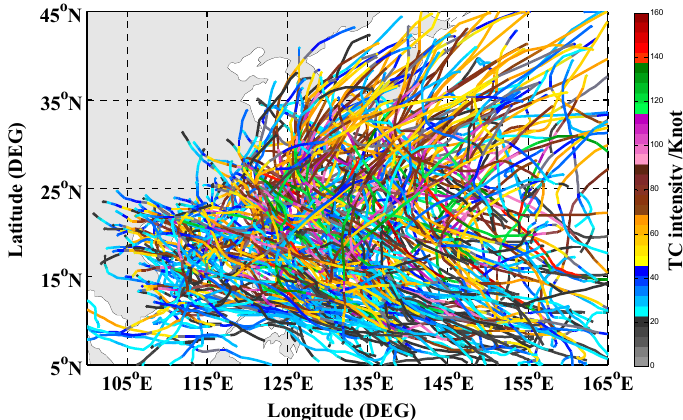
Figure 1. The region of interest in this paper, and tracks of the 325 cases adopted in training the model. The selected dataset comprises 18,108 three-hourly satellite images of 377 tropical cyclone cases from 1996 to 2009 NWP typhoon season. Of the 377 cases, 118 are tropical depression, 53 are tropical storm, 54 are typhoons, 36 are moderate typhoons, 26 are severe typhoons, 57 are super typhoons, and 33 are extreme typhoons. The 377 cases are divided into two groups. They are, 325 (16,126 images) from 1996 to 2007 and 52 (1982 images) from 2008 to 2009 typhoon seasons, performing as training and validation datasets, respectively. More specifically, of all the 16,126 training images, 4752 are tropical depression (29.47%), 5513 are tropical storms (34.19%), 2444 are typhoons (15.16%), 1522 are moderate typhoons (7.70%), 910 are severe typhoons (5.64%), 1041 are super typhoons (6.46%), and 252 are extreme typhoons (1.39%), as shown in Figure 1 and Table 1. Table 1. Number and percent of images in each category of tropical cyclones for training and validating the model. The terminologies of the typhoon categories are included in the brackets behind the category number.